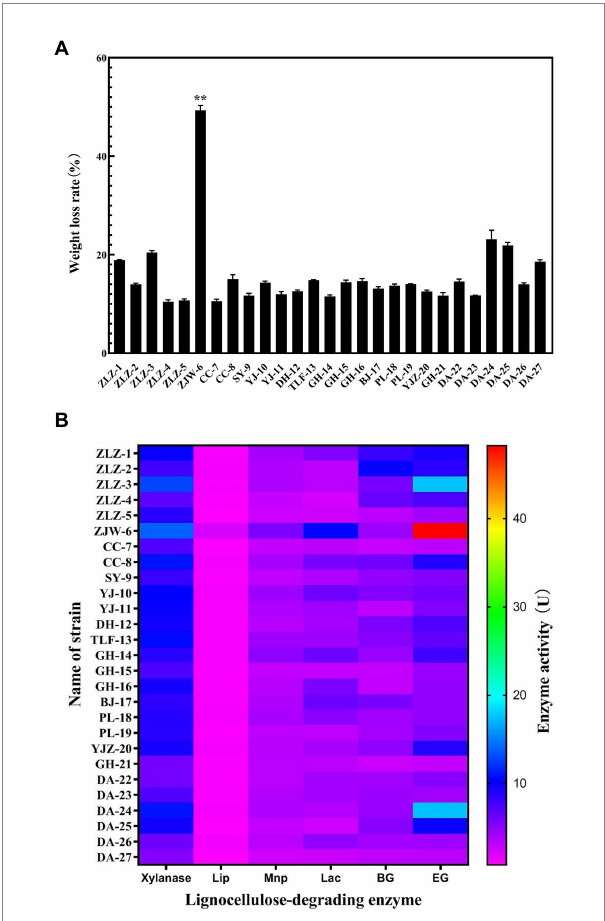
FIGURE 1 Characteristics of lignocellulose degradation of the strains isolated from soil samples. (A) The weight loss rate of rice straw after treated with 27 strains; (B) Heatmap of lignocellulose degrading enzyme activity of 27